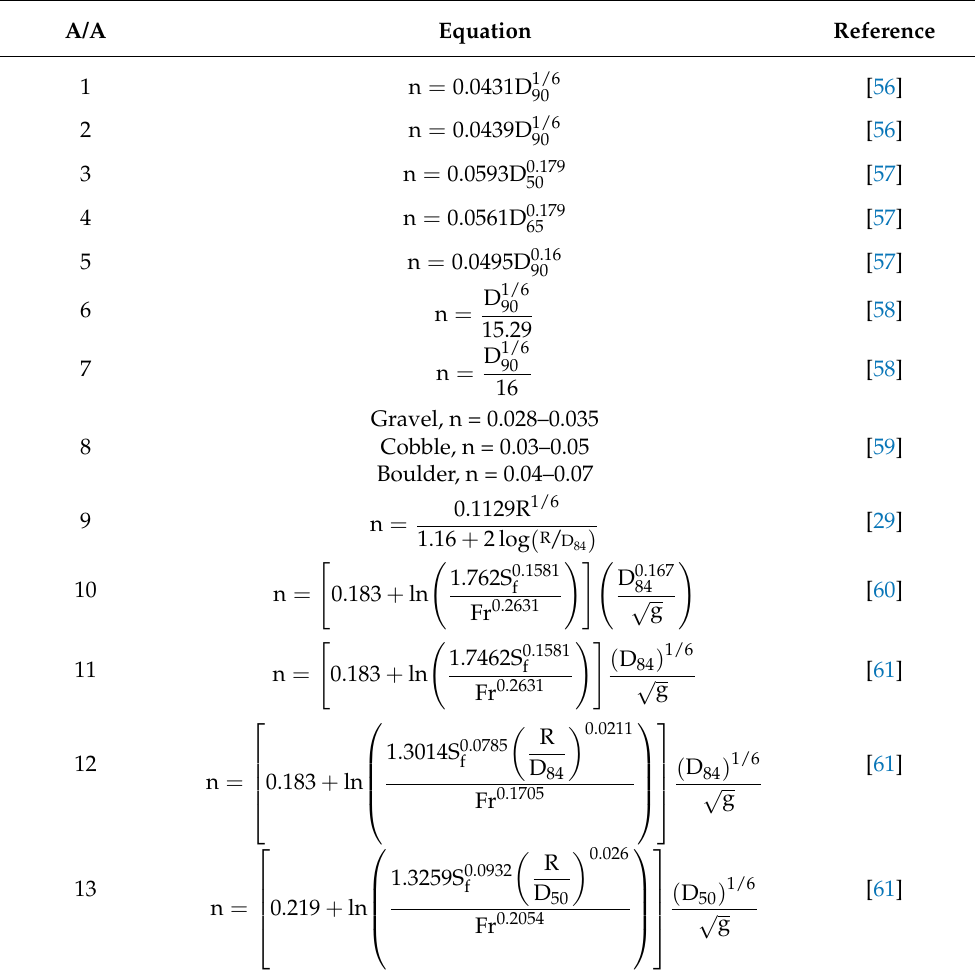
Table 3. Empirical relationships proposed by the international literature for assessing Manning’s roughness coefficient (n) values. A/A Equation